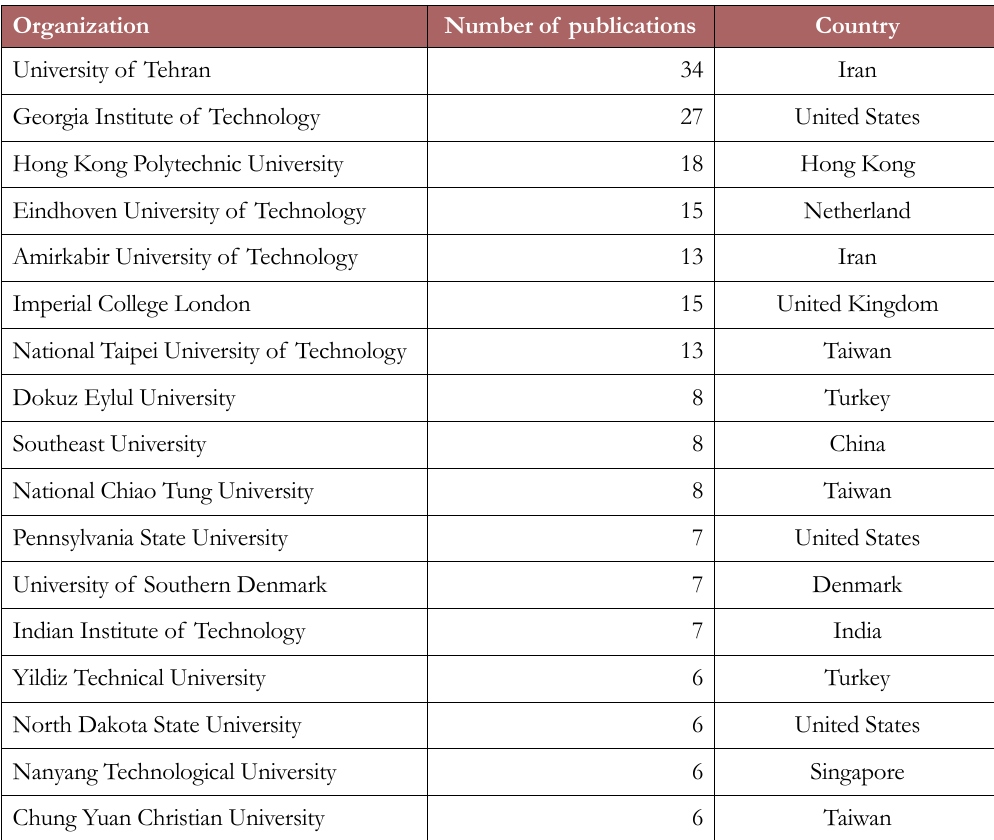
Table 6. The 17 top organizations with 6 or more